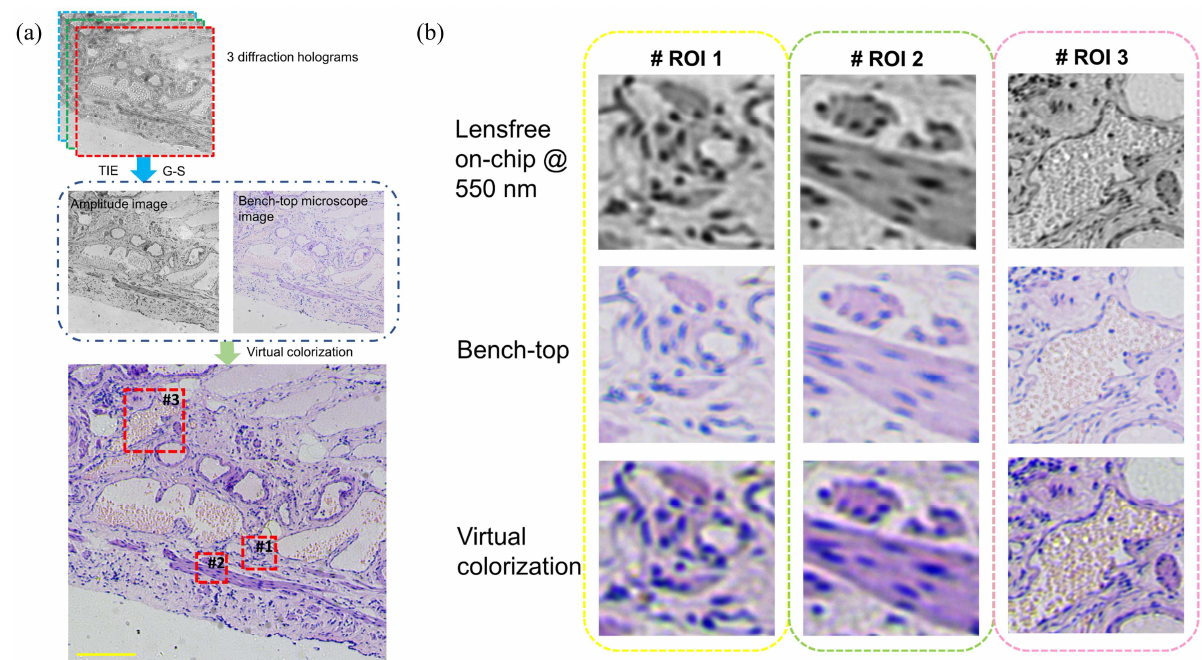
Figure 4. ( a , b ) Deep learning virtually colorizing to achieve colorful lens-less microscopy [57].